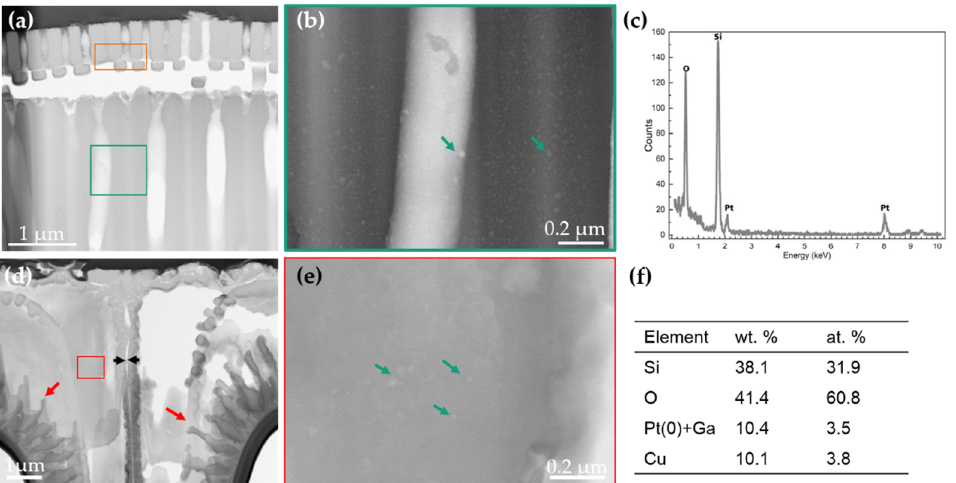
Figure 4. TEM imaging and chemical composition analysis of Ellerbeckia ( a – c ) in the area of the valvocopula and Melosira ( d – f ) in the linking region of the two valve faces. (a) Image of the region of the valvocopula, (b) image of the green area in (a) at a higher magnification, (c) spectrum of elements in the orange area of (a), (d) image of the linking region of the two valve faces, (e) high-magnification image of the red area in (d) and (f) area spectrum of elements in the red area. Green arrows: nanopores; red arrows: tube processes; black arrows: a special structure to link the two valve faces. Pt and Ga content arises from the FIB preparation, and Cu is from the sample holder.